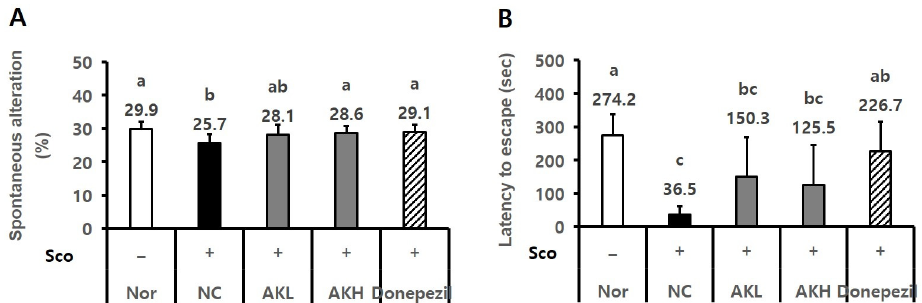
Figure 7. Learning and memory improvement effects of AK extract on chronically scopolamine- treated rats in ( A ) the Y-maze test and ( B ) the passive avoidance test. The rats were randomly divided into five groups: Nor: normal, commercial diet + saline; NC: negative control, commercial diet + scopolamine in saline; AKL: commercial diet of AK extract 0.14% + scopolamine in saline; AKH: commercial diet of AK extract 0.42% + scopolamine in saline; Donepezil: commercial diet + Donepezil 1 mg/kg in saline + scopolamine in saline ( n = 8 for Y-maze and n = 6 for PAT). All rats, except those in the normal group, were intraperitoneally administered scopolamine (1 mg/kg/day) for 21 days. Food and water were freely accessible. Statistical analysis was performed using SAS software. The values indicated with different letters were observed to differ significantly at p < 0.05 by Duncan’s multiple range